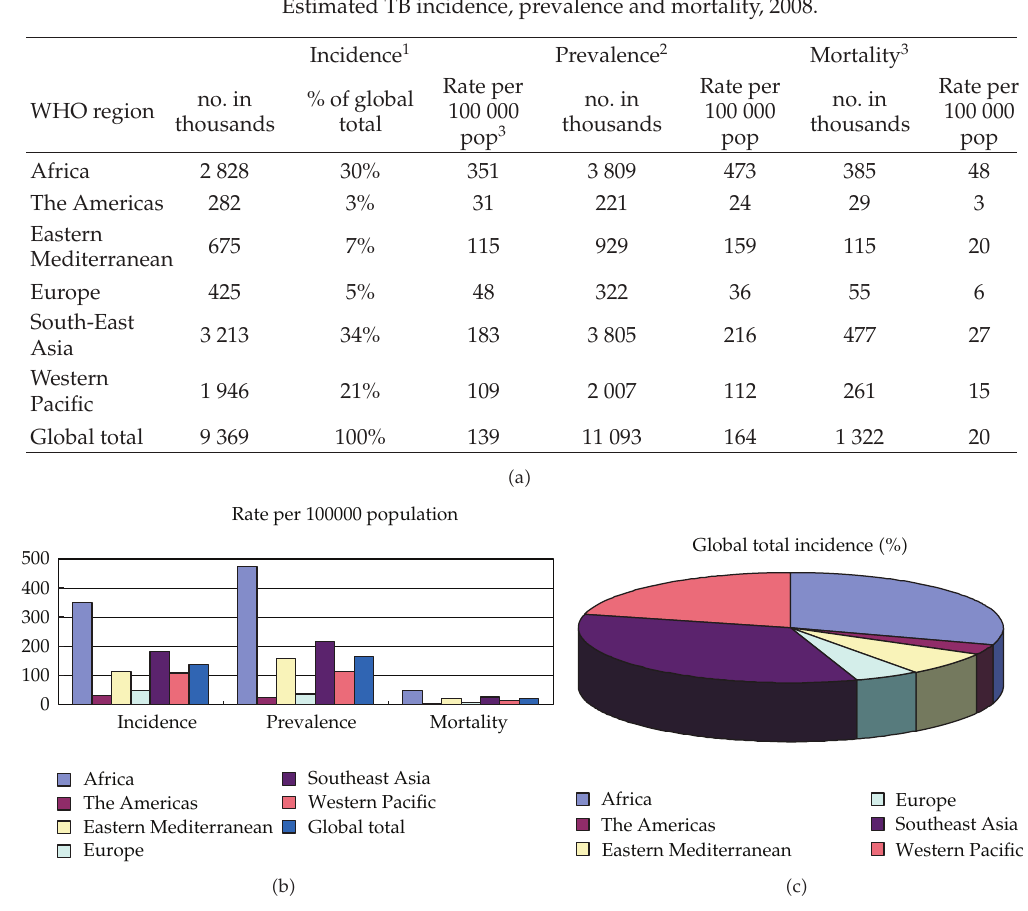
Figure 1: The estimated TB incidence, prevalence, and mortality in di ff eren regions in